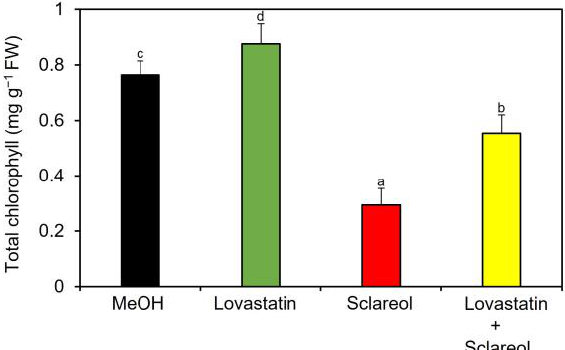
Figure 6. Effect of lovastatin on sclareol- induced reduction in chlorophyll. Arabidopsis plants were treated by soaking their roots in a solution containing 100 μ M lovastatin, 100 μ M sclareol, or a 50:50 mixture of lovastatin and sclareol for 48 h. The leaves of the treated plants were collected and the contents of total